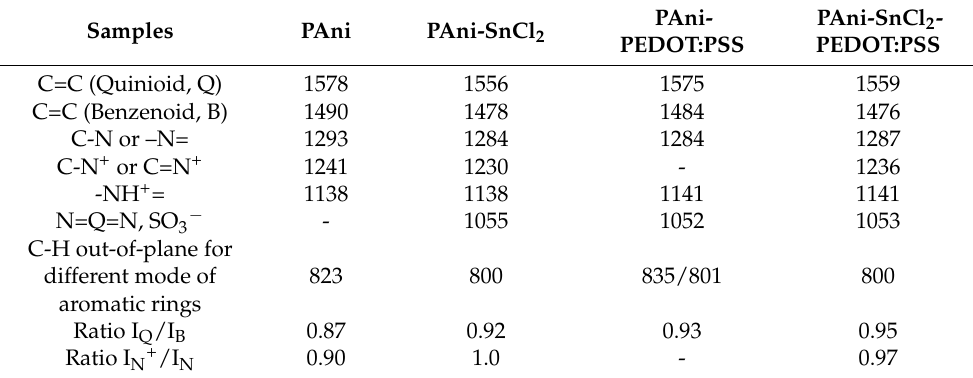
Table 1. FTIR spectral data of the different composites based on PAni (cm − 1 ). The blends with PEDOT:PSS contained 3 wt% of this